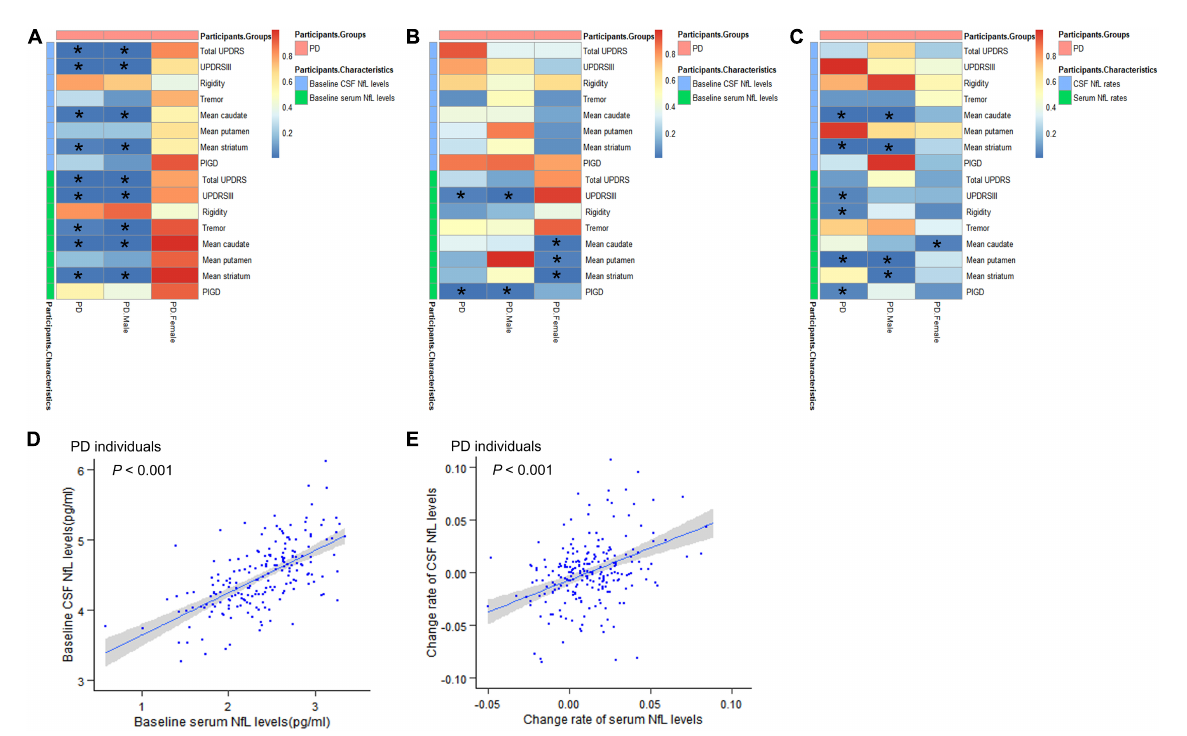
FIGURE2 Associations between motor features and NfL levels in cross-sectional and longitudinal analyses. (A) Associations between motor features and NfL levels in cross-sectional analyses. (B) Effects of baseline NfL levels on biomarkers and motor features among participants with PD during follow-up. (C) Associations between longitudinal changes in scores of motor features and change rates of NfL levels. (D) The relationship between baseline serum NfL levels and baseline CSF NfL levels. (E) The relationship between change rates of serum NfL levels and change rates of CSF NfL levels. CSF, cerebrospinal fluid; PD, Parkinson’s disease patients; NfL, neurofilament light; UPDRS, Unified Parkinson’s Disease Rating Scale; PIGD, postural instability and gait disorder. * P <